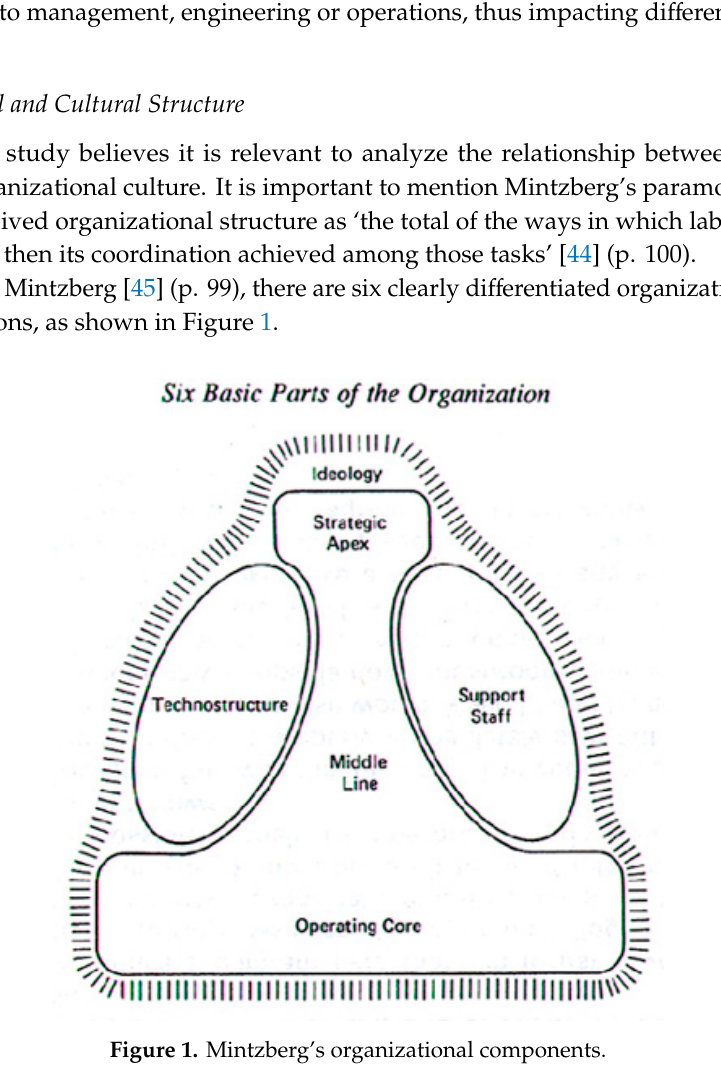
Figure 1. Mintzberg’s organizational components.